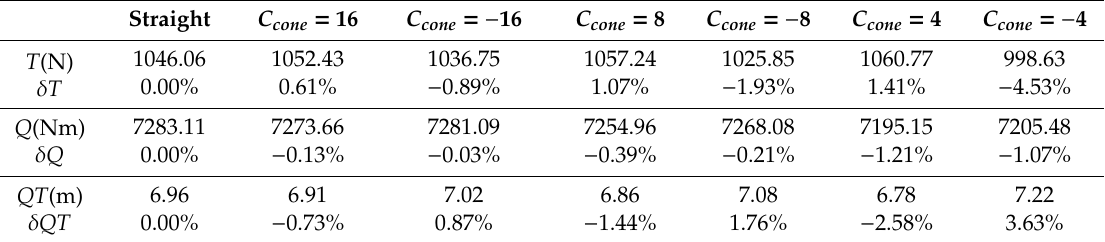
Figure 6. Spanwise force distributions of one standard rotor and six coned configurations ( T trans = 5 / R ) at 9m / s: ( a ) tangential force; ( b ) torque; ( c ) normal force; ( d ) magnified view of normal force. Table 3. Thrust and torque of one standard rotor and six coned configurations ( T trans = 5 / R ) at wind speed 9 m /